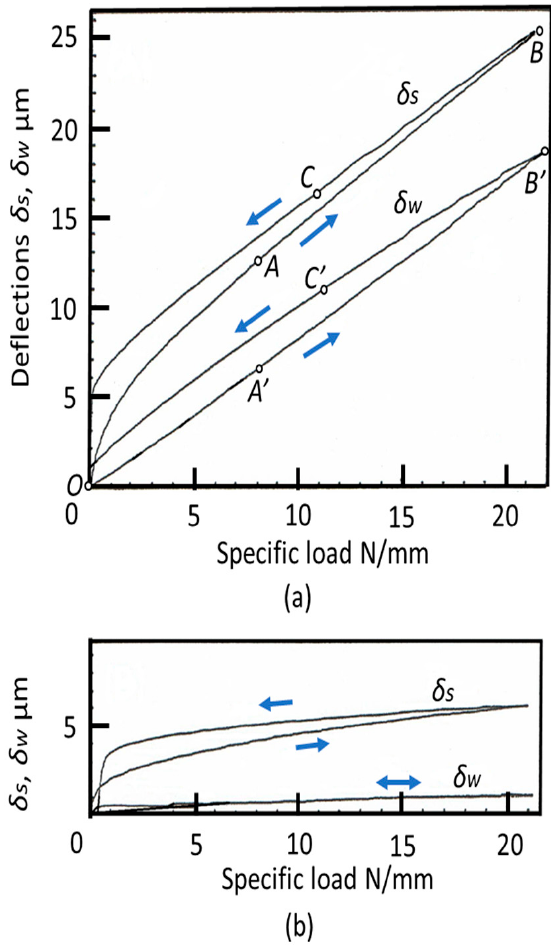
Figure 11. Deflections of wheel and workpiece under loading and unloading with grinding wheel WA60J8V. ( a ) Without load compensator; ( b ) With load compensator.